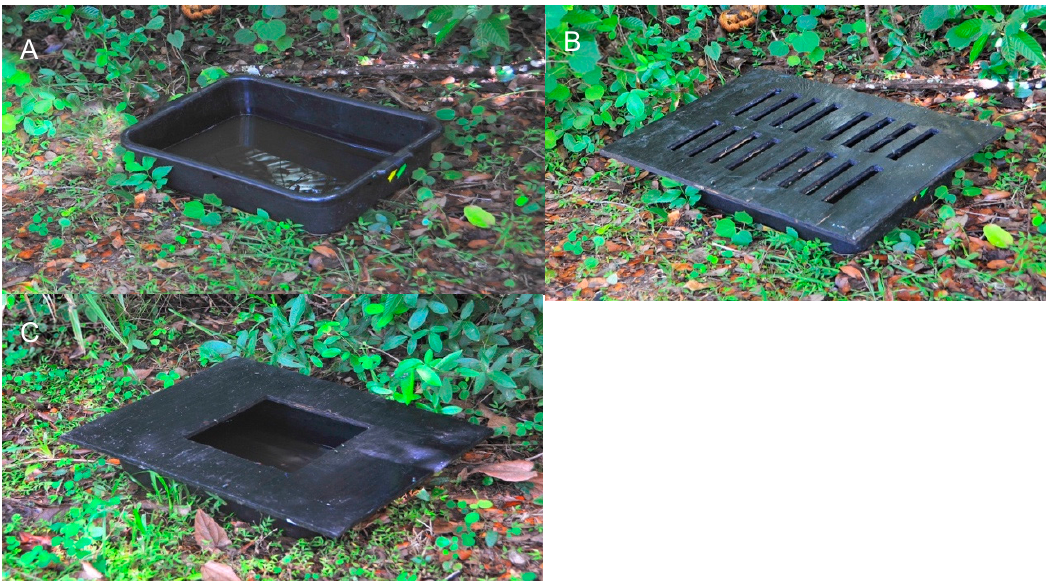
Figure 2. Vats with two different covers for characterizing Culex spp. oviposition behavior. ( A ) Hay infusion water in a vat.; ( B ) Ovitrap cover with storm drain type openings; (C) Ovitrap cover with a single large opening.